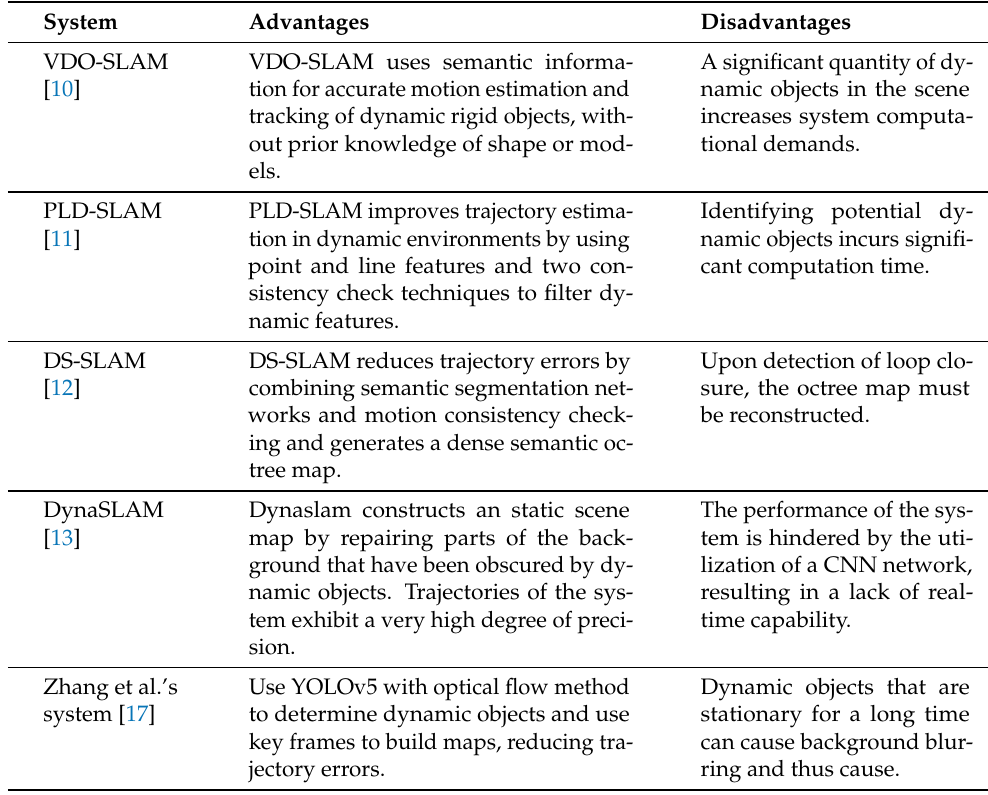
Table 1. Summary of related work with advantages and